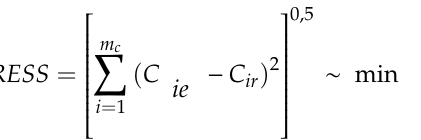
Figure 2. Regression dependency between values of TBN predicted by an FTIR-PLS model and values determined by a standardized Č SN ISO 3771 method.